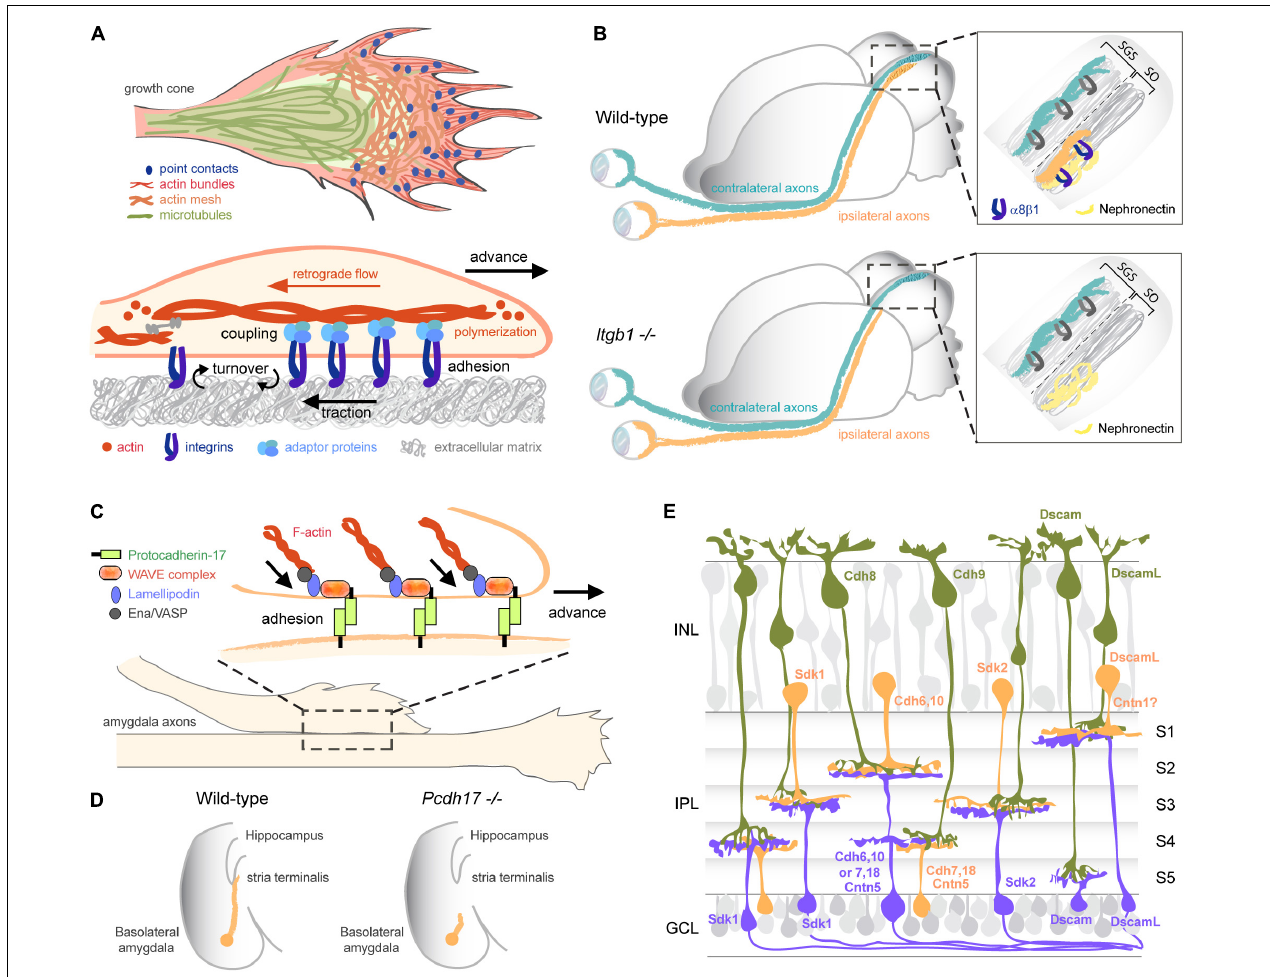
FIGURE 2 | Adhesive functions of CAMs in circuit wiring. (A) Integrins mediate adhesion to the ECM for growth cone advance. Binding of integrins to ECM ligands leads to the clustering of integrins and the recruitment of adaptor proteins linking integrins to the actin cytoskeleton. The point contacts hence formed promote growth cone advance by stabilizing filopodial protrusions and restraining the retrograde flow of actin at the growth cone periphery. (B) Integrins mediate adhesion to the ECM for target selection. In the visual system, integrin α 8 β 1 is selectively expressed by retinal ganglion cells projecting ipsilaterally. Its ligand, the ECM glycoprotein Nephronectin, is restricted to a sublamina at the target. Interaction between integrin α 8 β 1 and Nephronectin is necessary for the laminar targeting of ipsilateral axons to the rostral stratum opticum (SO). Deleting integrin α 8 β 1 or Nephronectin causes a dramatic loss of ipsilateral projections while contralateral projections remain unaffected in the stratum griseum superficial (SGS). Adapted from Su et al. (2021). (C,D) Protocadherin-17 (Pcdh17) mediates trans -axonal interactions for proper tract formation. (C) Pcdh17 accumulates at homotypic contacts between growth cones and axons from amygdala neurons, where it recruits the WAVE complex, Lamellipodin, and Ena/VASP proteins that remodel the actin cytoskeleton and promote membrane protrusion. Pcdh17-mediated adhesion enhances growth cone motility and enable growth cone advance along homotypic axons. (D) Pcdh17 is required for the extension of amygdala axons through the stria terminalis toward the hypothalamus. Adapted from Hayashi et al. (2014). (E) A CAM code specifies laminar targeting and synaptic specificity in the retina. Sdk1, Sdk2, Dscam, DscamL, and Cntns (not all a represented here) are expressed in non-overlapping subsets of bipolar (green), amacrine (orange), and retinal ganglion cells (purple) and engage in homophilic trans- interactions to direct synapse formation between matching partners in specific laminae (S1–S5) of the inner plexiform layer (IPL). Classical cadherins (Cdh) also contribute to the molecular code specifying connections. INL, inner nuclear layer; GCL, ganglion cell layer. Adapted from Sanes and Zipursky